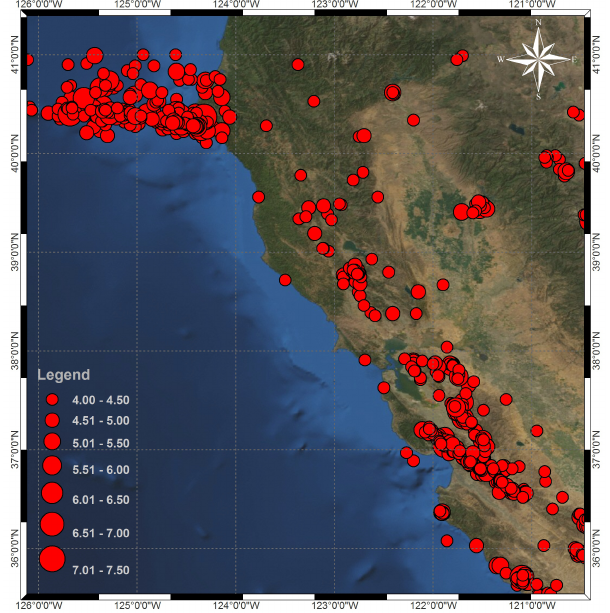
Fig. 10. Locations of the northern California earthquakes with M ≥ 4 for the period 1970 to 2009.